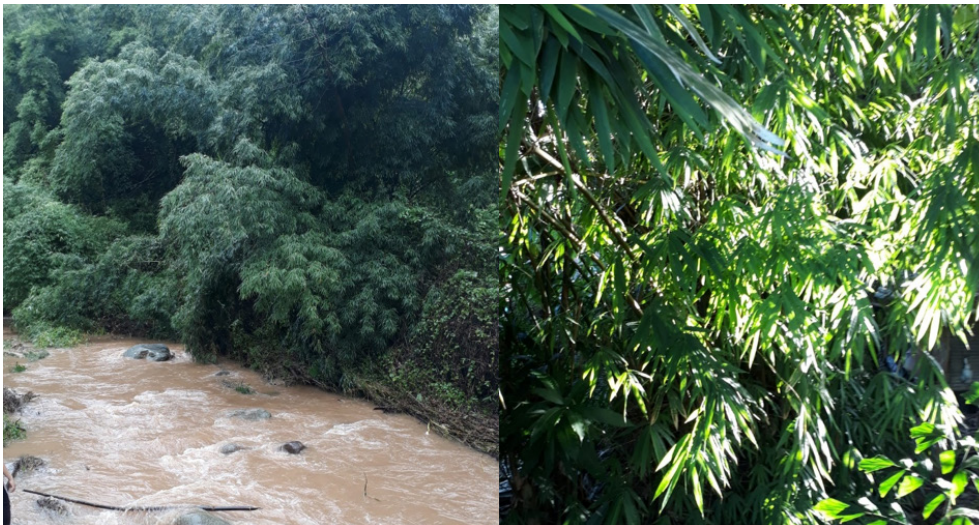
Figure 3: Dendrocalamus sp. are often discovered close to streams. Location: Doi Hang, Chiang Rai, Thailand. © Binu Samarakoon, Center of Excellence in Fungal Research, Mae Fah Luang University, Chiang Rai,